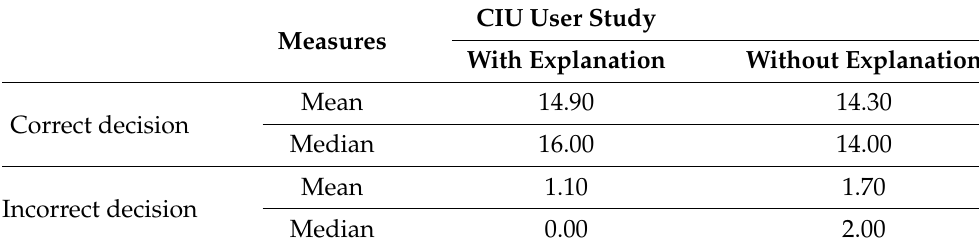
Table 8. Mean and median values of CIU users’ decision-making.